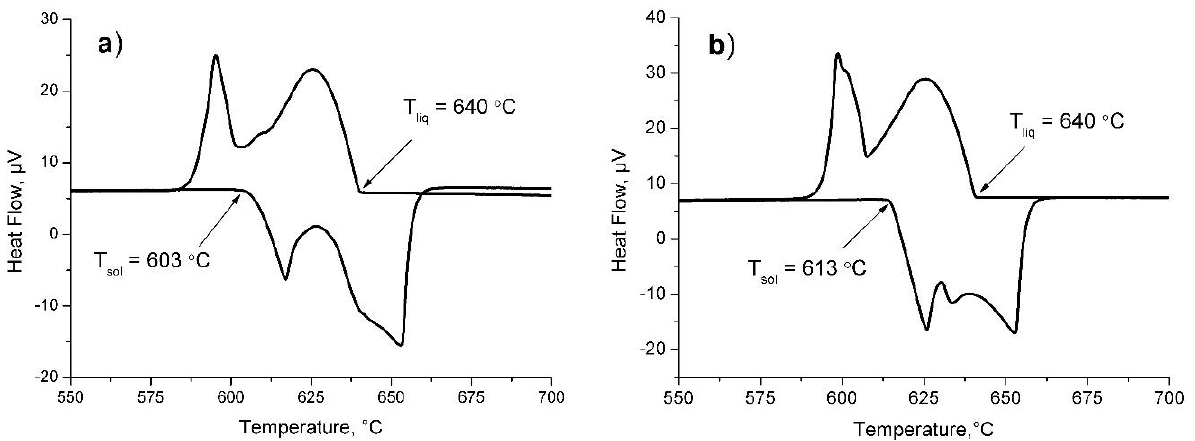
Figure 4. DSC curves of the as-cast AlCuYbZr ( a ) and AlCuGdZr ( b ) alloys (heating-bottom curves; cooling-top curves).